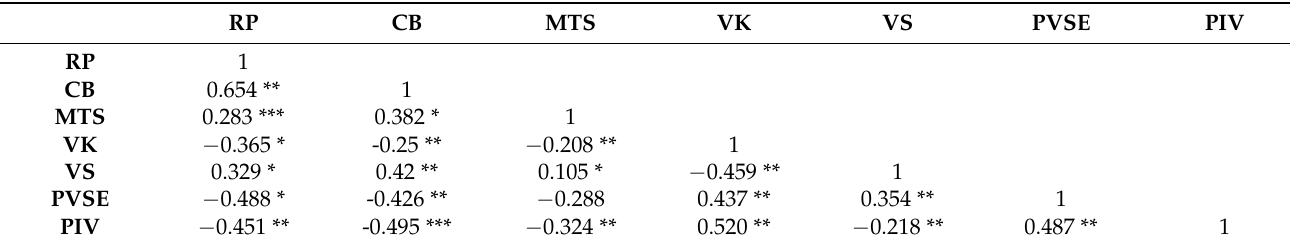
Table 4. Correlation Matrix among the